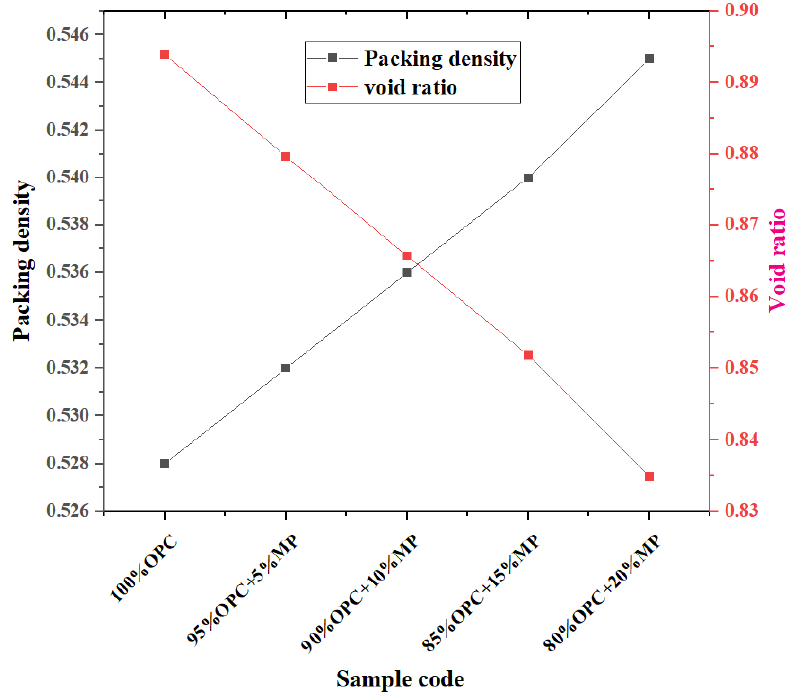
Figure 6. Differentiation of void ratio and packing density at different MP contents.